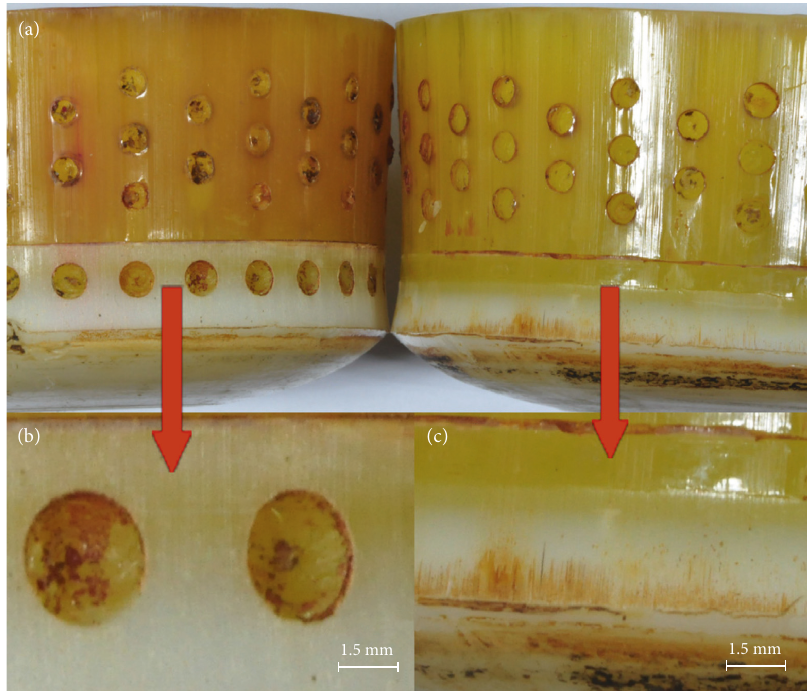
Figure 5: Wear patterns of the piston leather cup root with and without dimples: (a) comparison chart of root wear of the L-D4 and L-D2 pistons, (b) partial enlarged diagram of root wear of the L-D4 piston, and (c) partial enlarged diagram of root wear of the L-D2 piston.